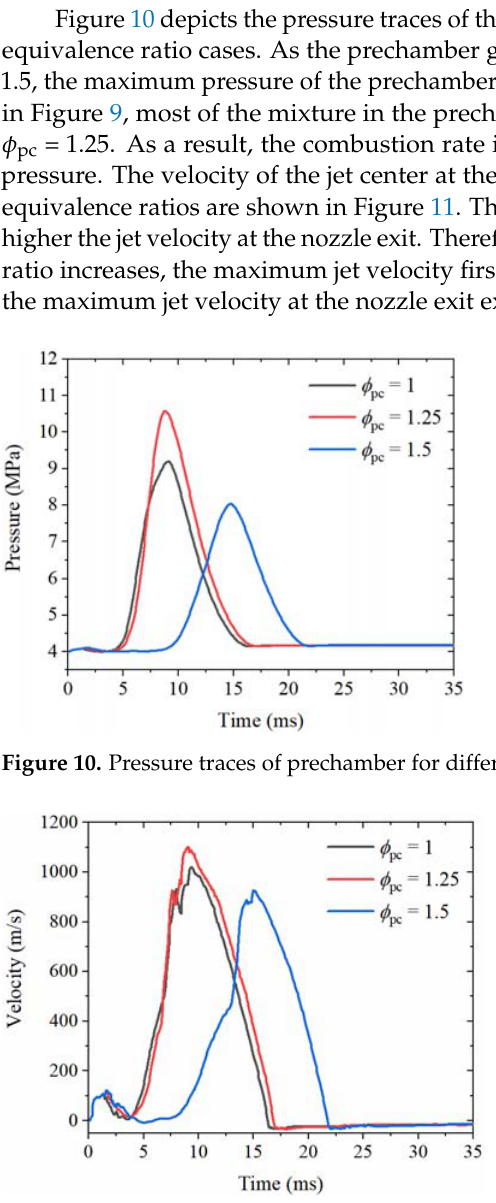
Figure 11. Velocity of jet center at nozzle exit for different prechamber global equivalence ratios.